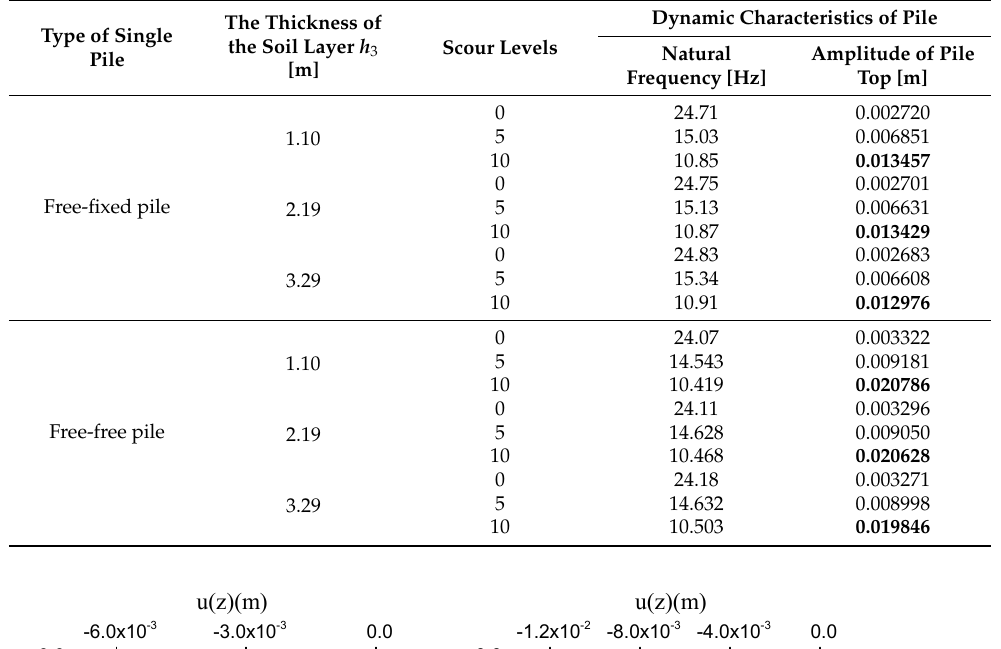
Table 3. Effect of the thickness of the underlying soil on dynamic characteristics of the single pile under varied scour levels.